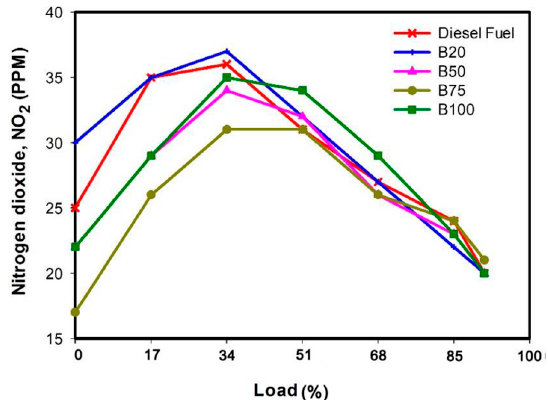
Figure 13. Variations of NO 2 with engine load for diesel, sheep fat biodiesel (B100) and biodiesel blends (B20, B50 and B75) fuels.